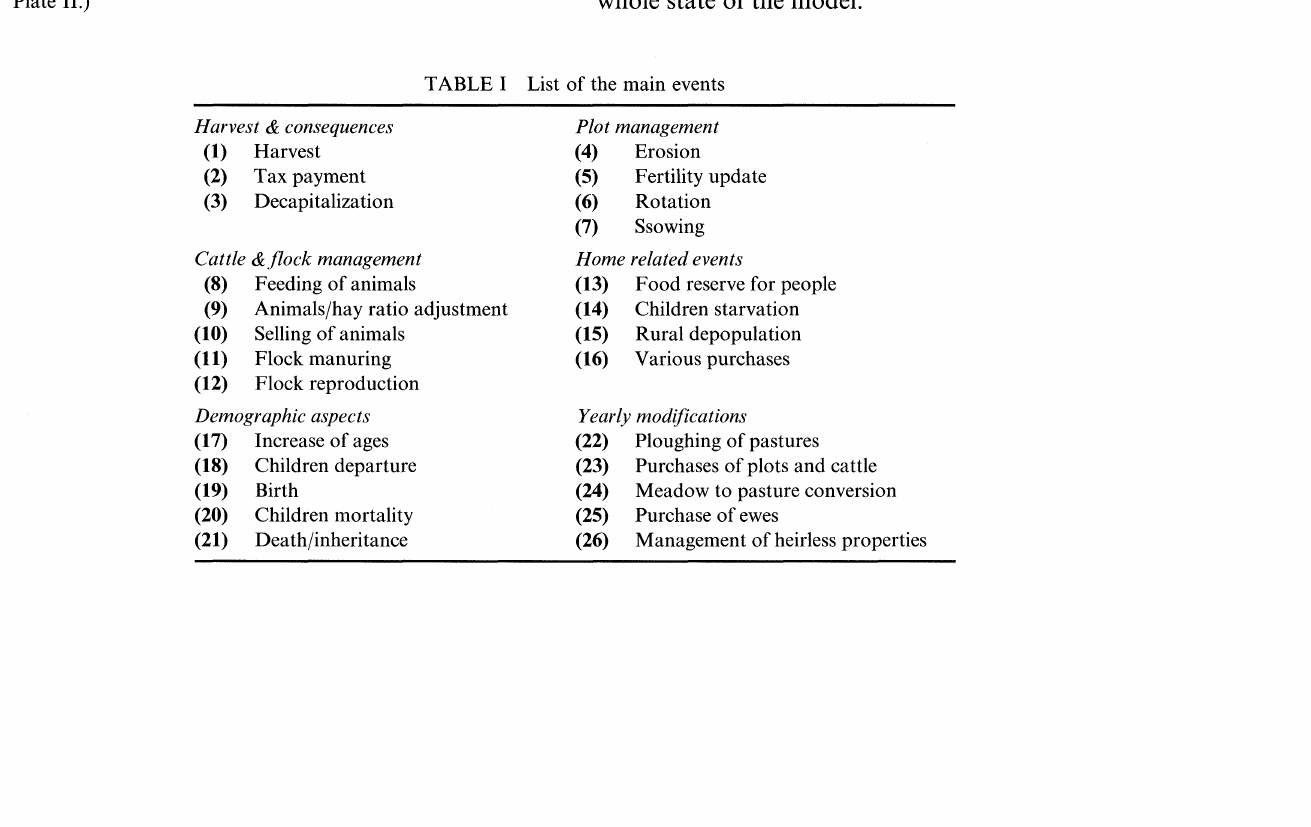
FIGURE 2 Calendar of regular annual events. (See Colour Plate